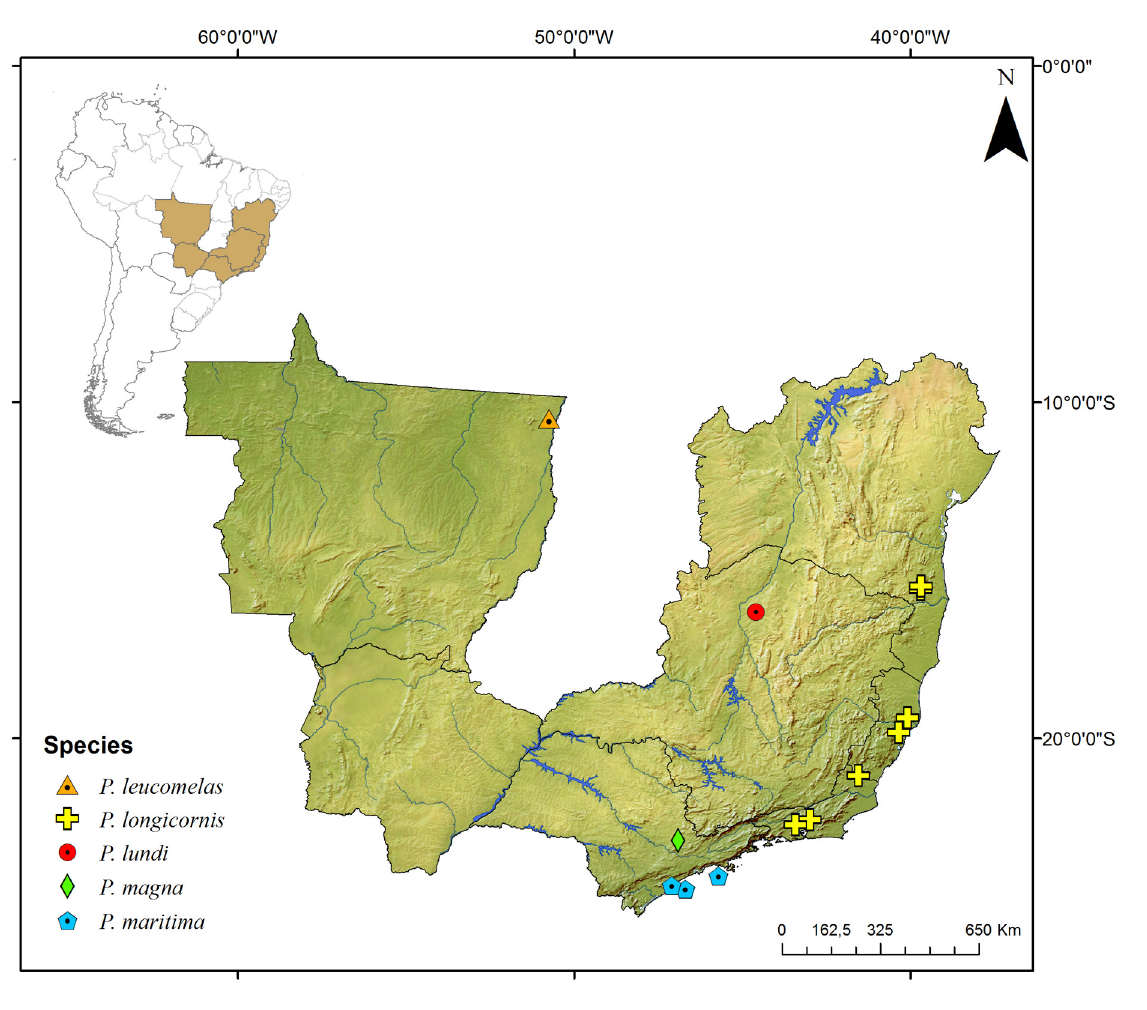
Fig. 184. Distribution map of the species Pseudonannolene leucomelas Schubart, 1947, P. longicornis (Porat, 1888), P. lundi Iniesta & Ferreira, 2015, P. magna Udulutsch & Pietrobon, 2003, and P. maritima Schubart,